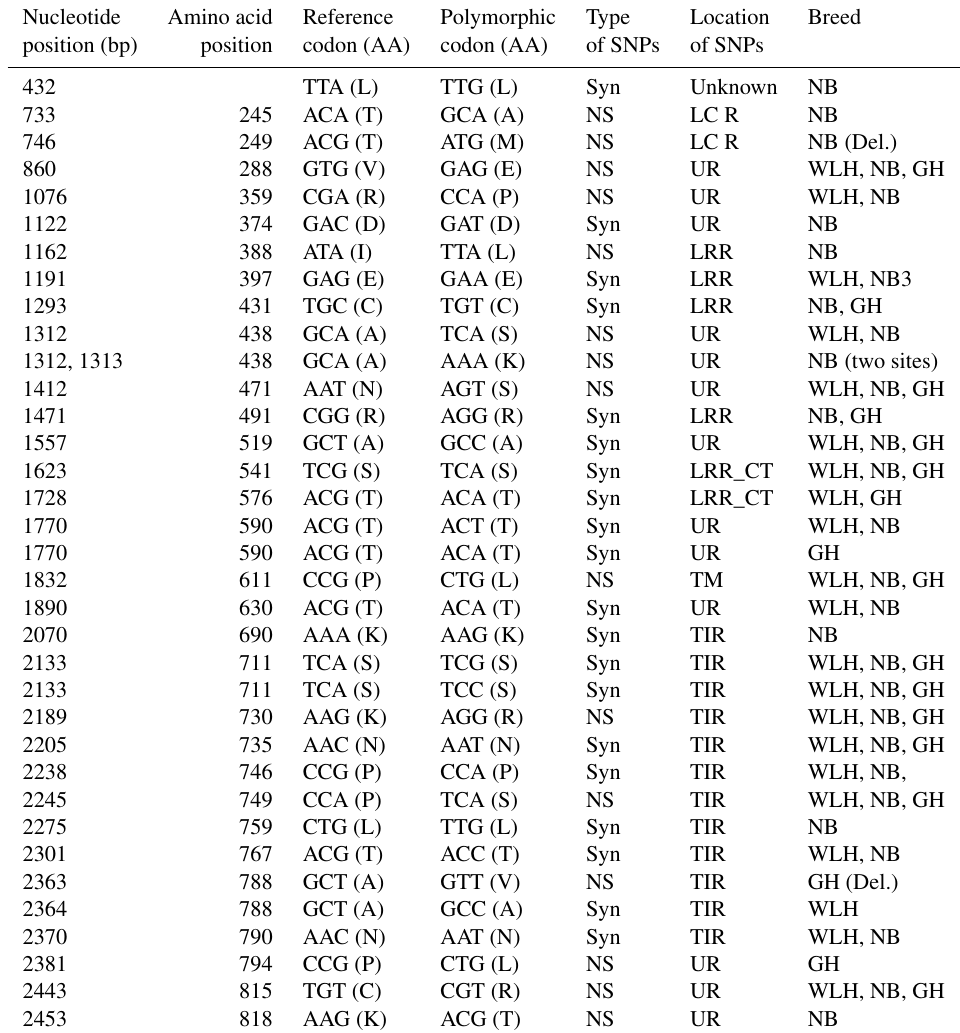
Table 3. Polymorphisms in the TLR1LA gene of different chicken breeds. Nucleotide Amino acid Reference